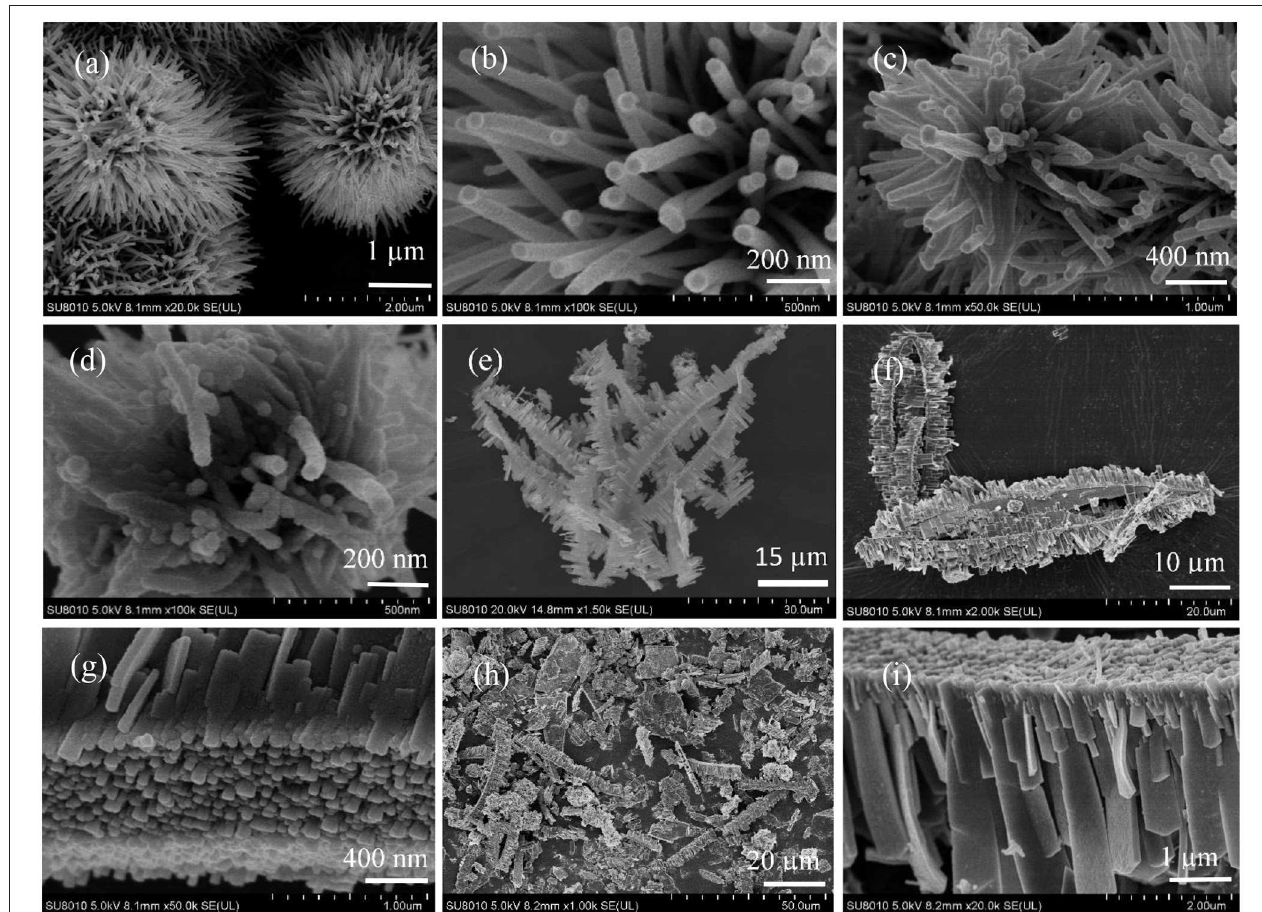
FIGURE 2 | SEM images of Ni 0.8 Cu 0.2 O (a,b) , Ni 0.6 Cu 0.4 O (c,d) , Ni 0.4 Cu 0.6 O (e–g) , and Ni 0.2 Cu 0.8 O (h,i) .